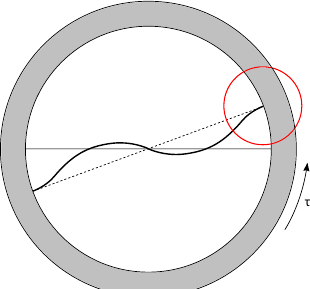
Figure 8. The leaf spring (thick solid line) is fixed to the output of the variable stiffness actuator (VSA) mechanism (grey ring), which causes the leaf spring slope at its ends (dashed line) to be coincident with the mechanism center and perpendicular to the tangent of the output ring.